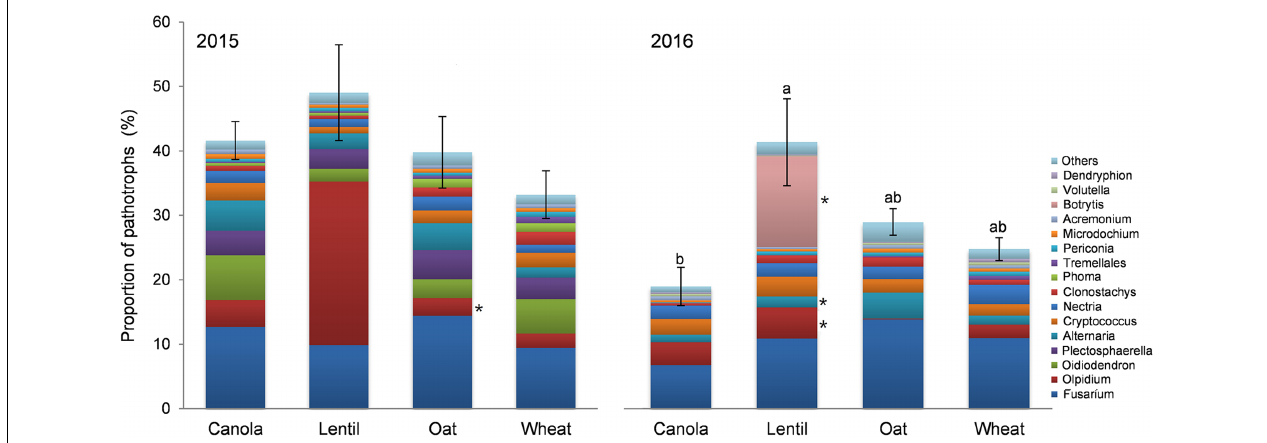
FIGURE 10 | Effect of previous crop on the relative abundance of fungal genera ( > 0.25% of total reads) assigned to trophic mode of pathotrophs (mean ± SE) in 2015 and 2016. The effect of previous crop was insignificant in 2015. Bars with different letters indicate a significant difference in the relative of pathotroph reads ( P < 0.05). Different color bar of fungal taxa with an ∗ indicates a significant effect of previous crop on the proportion of pathotrophs’ reads at P <